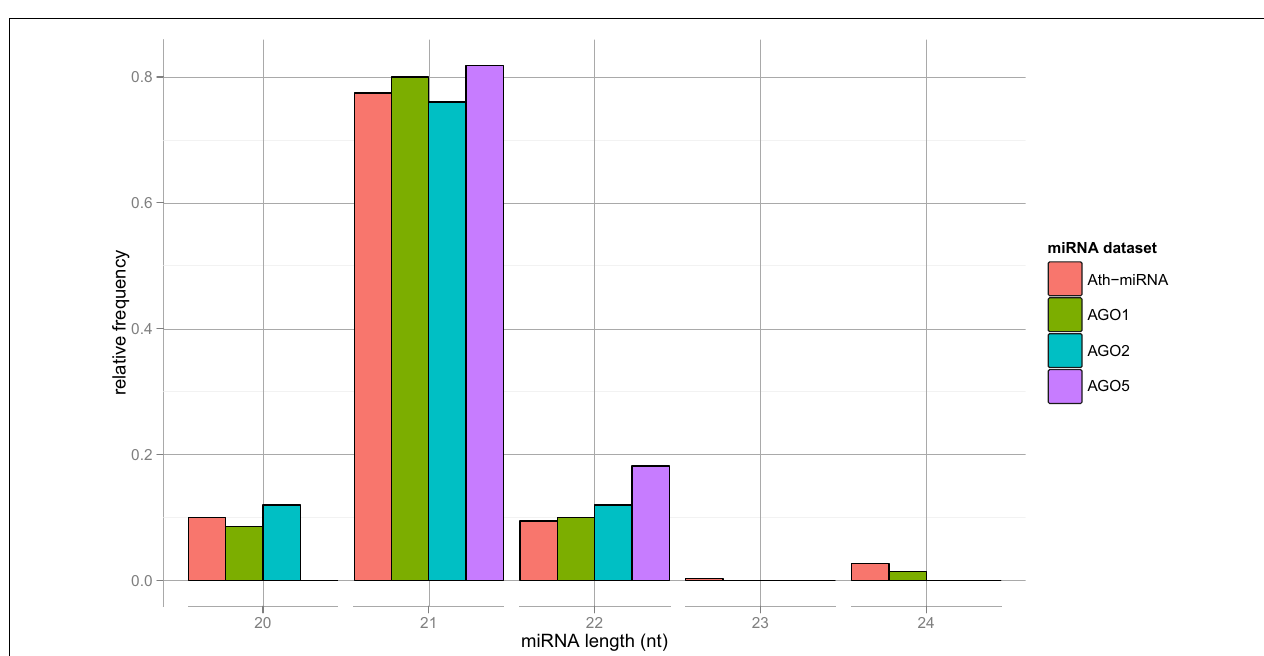
FIGURE 1 | Length distribution of all Arabidopsis (Ath) miRNAs as contained in miRBase, and for sequence-unique miRNA found to be specifically associated withAGO proteins 1, 2, and 5, respectively (the Confidence Set ).